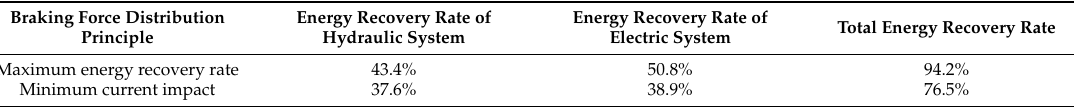
Table 4. Simulation results of various braking modes.